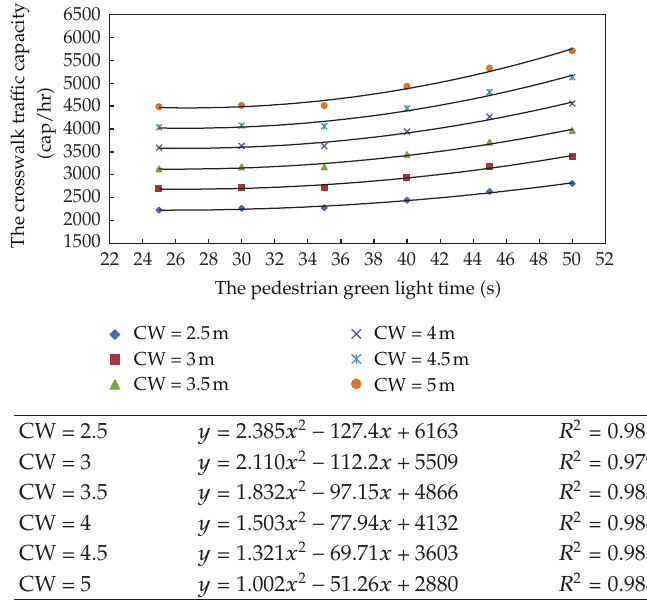
Figure 4: Relationship between pedestrian tra ffi c capacity of crosswalk and green